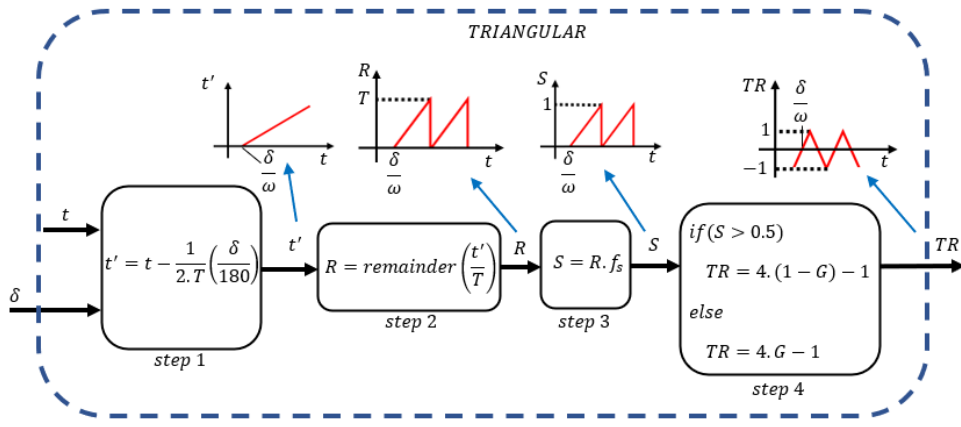
Figure 9. Block diagram for generation of the triangular waveforms used in the modulator.